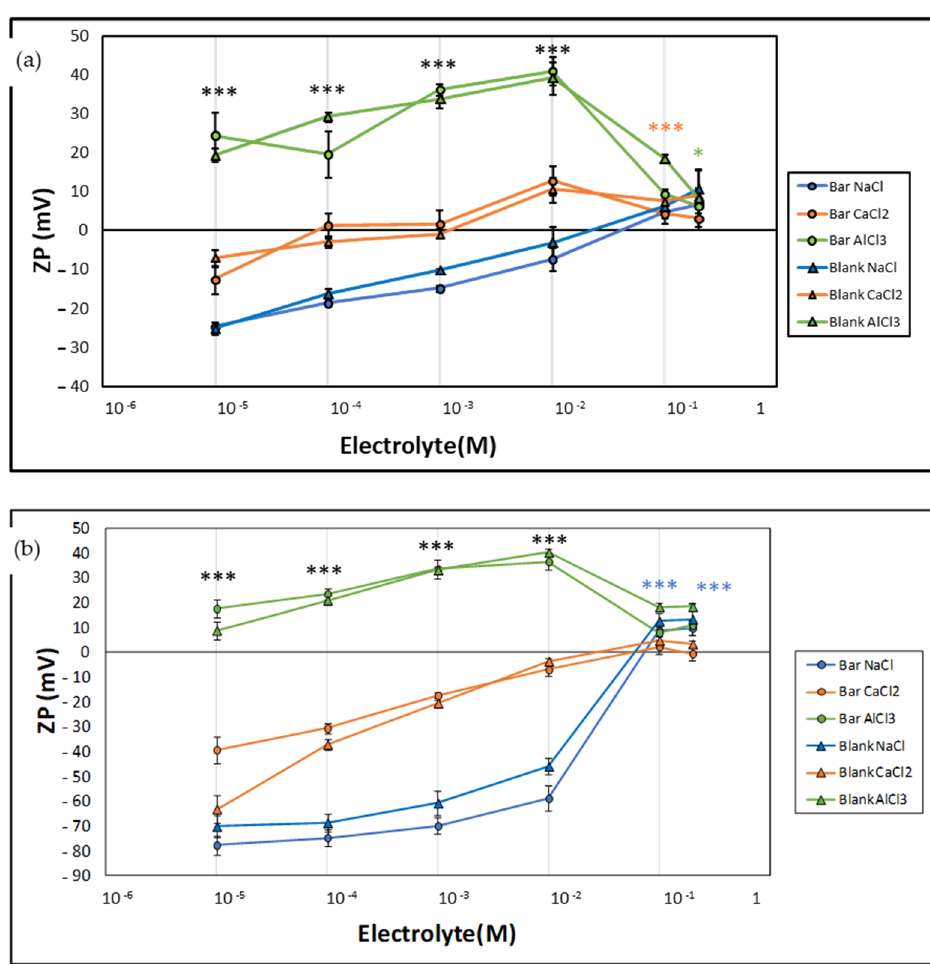
Figure 4. ZP of liposomes as a function of the concentration of NaCl, CaCl 2 , and AlCl 3 at pH 7.4. ( a ) L α -PC liposomes and ( b ) POPE:POPG liposomes. Each point represents the mean ± SD (n = 9). An ANOVA was conducted and then followed by Tukey analysis, considering three groups of electro- lyte types at each concentration for both liposomes L α -PC and POPE:POPG loading baricitinib. *** Statistical differences p < 0.0001 between all the electrolytes; *** Statistical differences p < 0.0001 between NaCl vs. AlCl 3 for L α -PC; * Statistical differences p < 0.05 between NaCl and CaCl 2 vs. AlCl 3 for L α -PC; *** Statistical differences p < 0.0001 between NaCl and AlCl 3 vs. CaCl 2 . L α -PC = L- α -phosphatidylcholine; POPE:POPG = 1-palmitoyl-2-oleoyl-phosphatidylethanolamine: 1-Palmitoyl-2-oleoyl-sn-glycerol-3-phosphoglycerol (3:1,